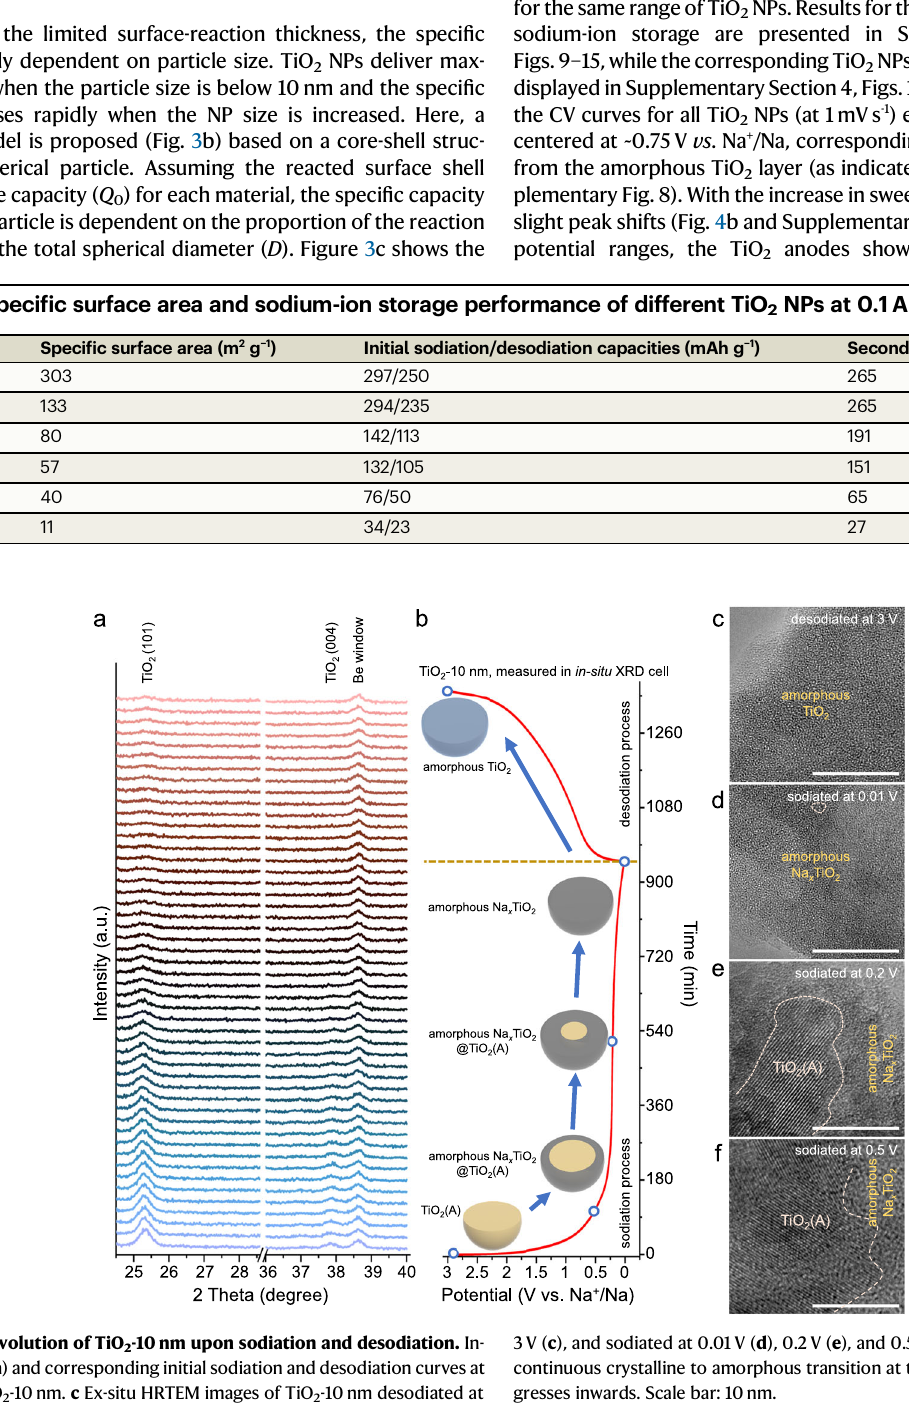
3V ( c ), and sodiated at 0.01V ( d ), 0.2V ( e ), and 0.5V ( f ). The images indicate a continuous crystalline to amorphous transition at the particle surface which pro- gresses inwards. Scale bar: